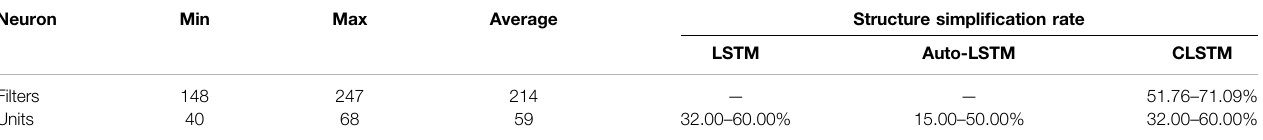
TABLE 4 | Distribution of the structural hyperparameters for 50 independent runs on the DKASC data